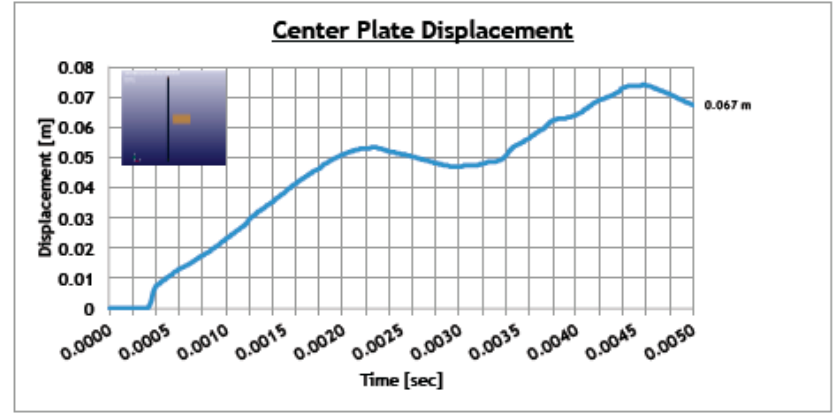
Figure 11. Von Mises stress and plastic strain.